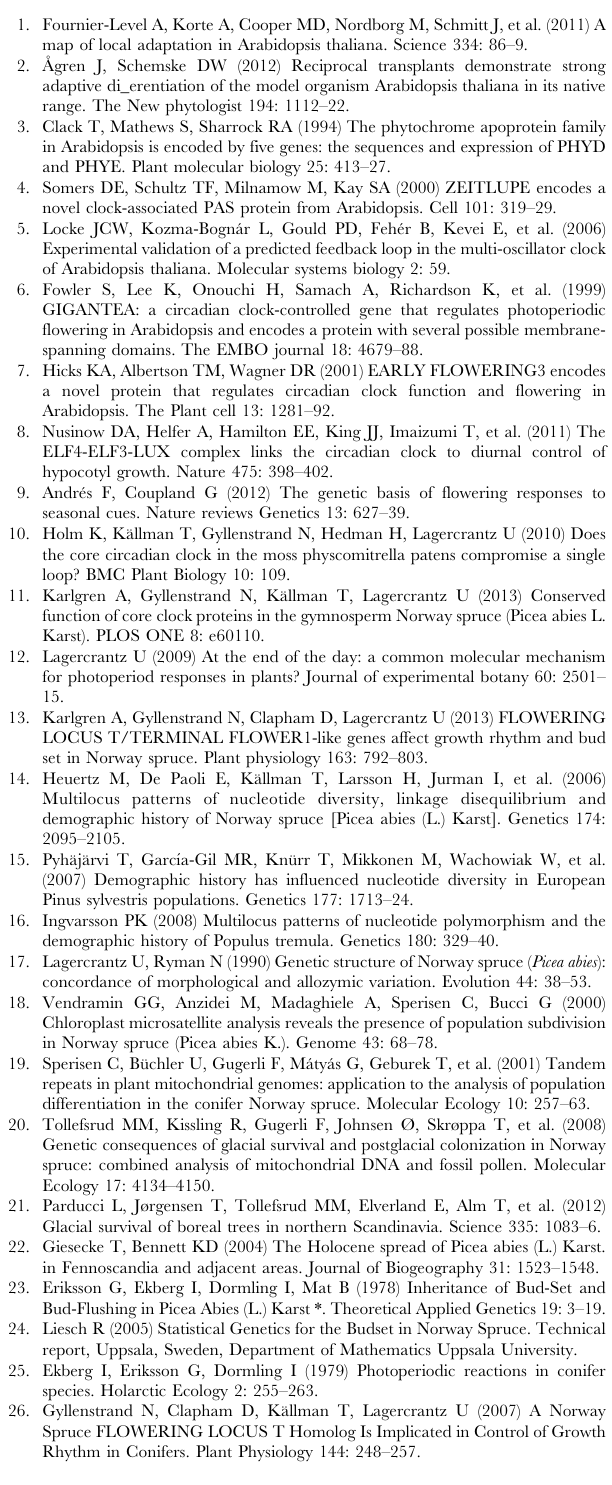
Figure S3 Density plots of parameters estimated with ABC using the Population Expansion model (PEM). Figure S4 Density plots of parameters estimated with ABC using the split and growth model